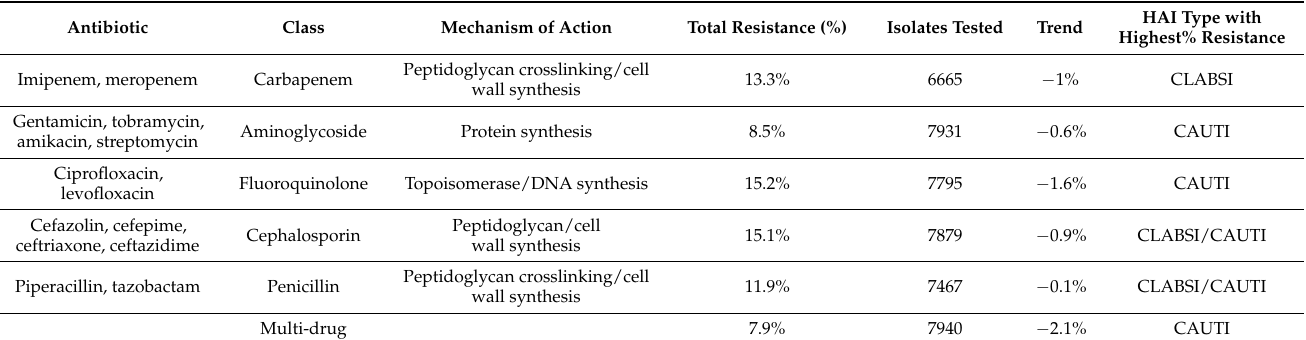
Table 1. Antibiotic resistance trends in clinical